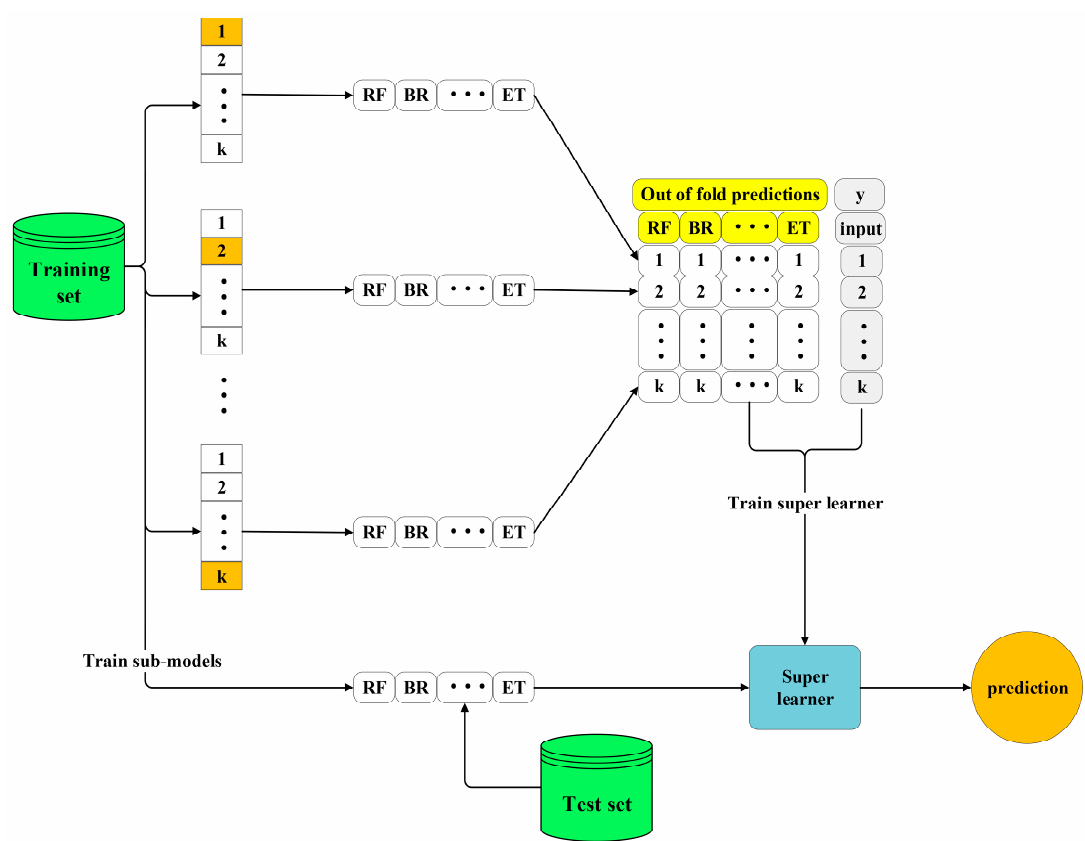
Figure 5. Flowchart of the SL technique.